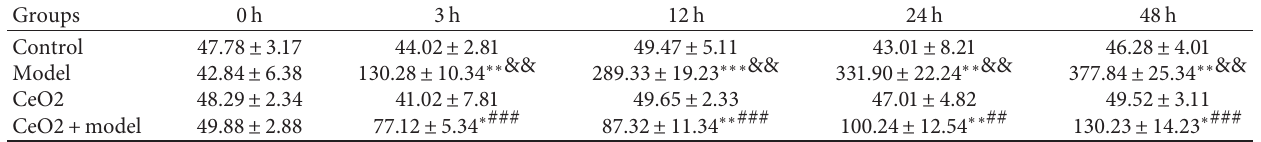
Table 2: TNF- α levels in peritoneal lavage fluid of each group of rats